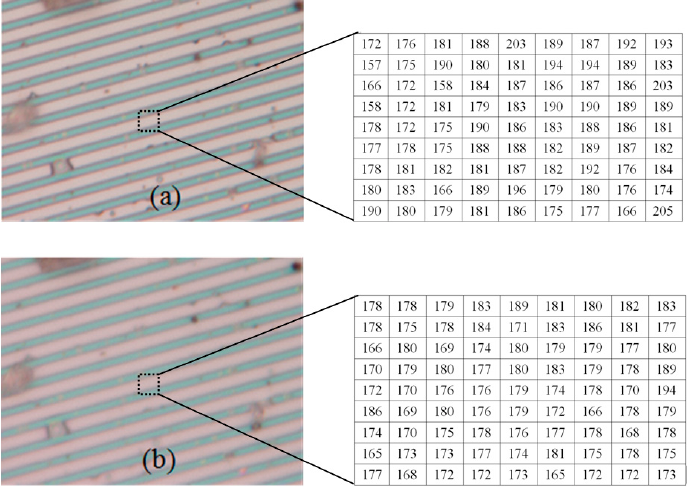
Figure 8. The blurred images of a nanogrid (the intensity values in the dotted rectangles are presented with two matrixes). ( a ) The blurred image before raising the platform; ( b ) the blurred image after raising the platform.